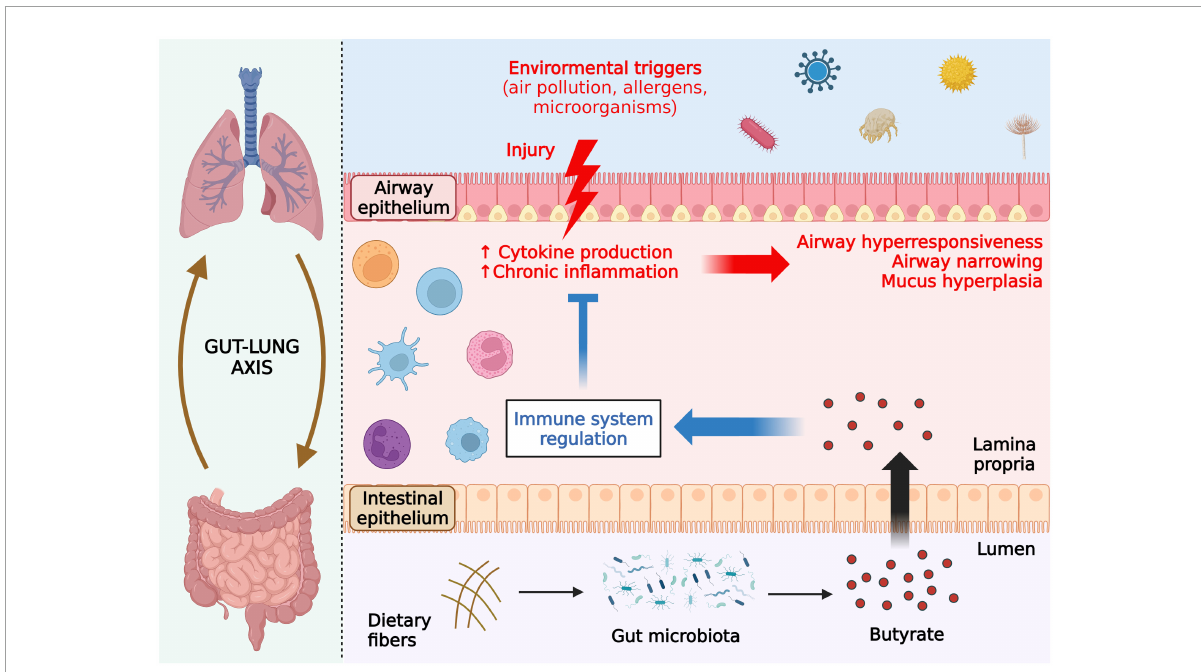
FIGURE4 Effects of butyrate in ameliorating allergic asthma. Allergic asthma is associated with sensitization to aeroallergens such as air pollution, bacteria, pollen, and viruses. Exposure to the allergen induces airway epithelial injury, triggering an inflammatory response with enhanced cytokine production and, consequently, airway hyper-responsiveness, narrowing, and mucus hyperplasia. Butyrate produced in the gut reaches the lungs through the bloodstream and regulates inflammatory cells through histone deacetylase (HDAC) inhibition, thus attenuating asthmatic symptoms and pulmonary damage. All figures were created with